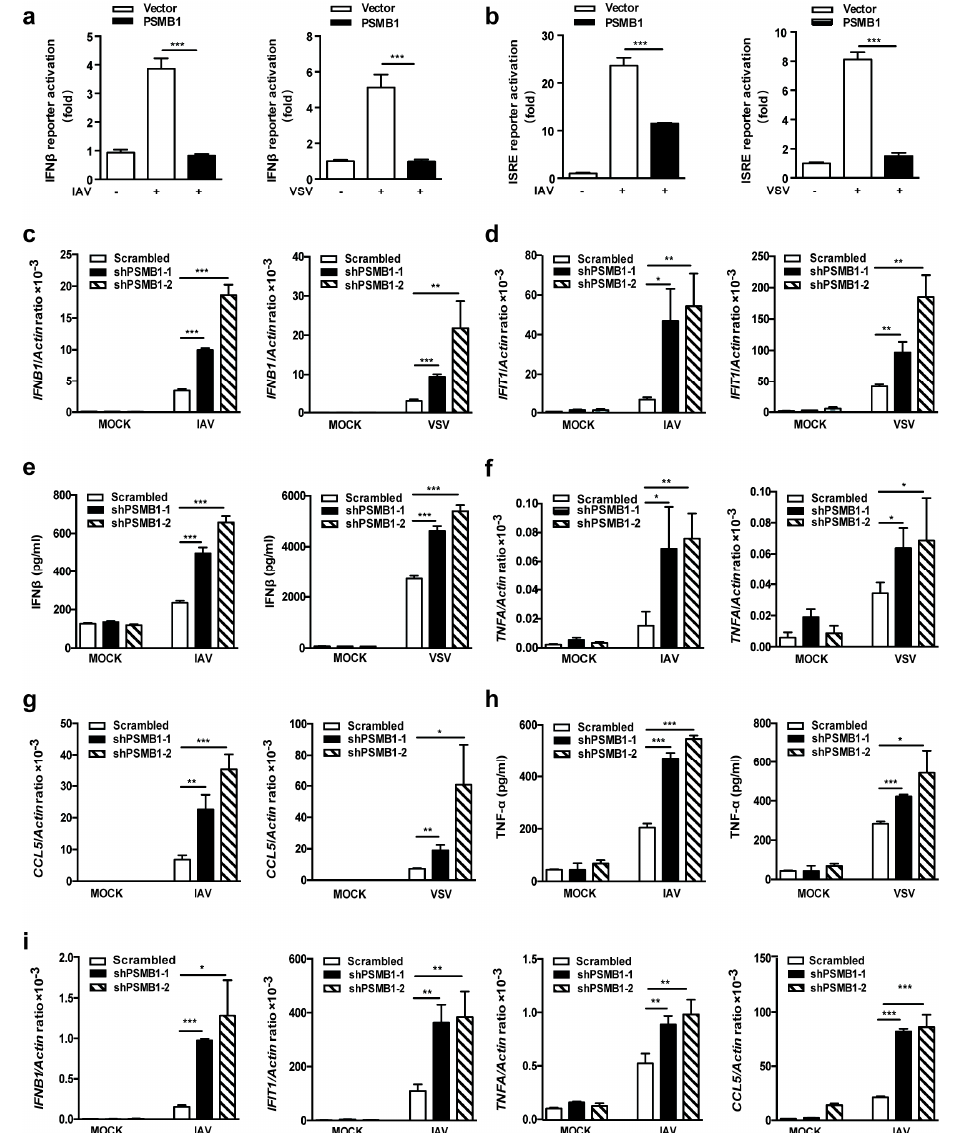
Figure 2. PSMB1 negatively regulates RNA virus-induced innate immune responses. ( a , b ) Quantification of IFN β and ISRE promoter activities in HEK293T cells transfected with either empty vector or PSMB1 plasmid after IAV or VSV infection. ( c – e ) Quantification of IFNB1 and IFIT1 mRNA levels by qPCR (c, d) and secreted interferon beta (IFN β ) protein levels (e) from HEK293T cells stably expressing either scrambled shRNA or PSMB1 -targeting shRNA after IAV infection (MOI = 1) for 24 h or VSV infection (MOI = 0.1) for 12 h. ( f – h ) Quantification of TNFA and CCL5 mRNA levels by qPCR (f, g) and secreted tumor necrosis factor alpha (TNF- α ) levels by ELISA (h) from HEK293T cells stably expressing either scrambled shRNA or PSMB1 -targeting shRNA after IAV infection (MOI = 1) for 24 h or VSV infection (MOI = 0.1) for 12 h. ( i ) Quantification of indicated cytokine and chemokine mRNA levels by qPCR from A549 cells stably expressing either scrambled shRNA or PSMB1 -targeting shRNA after IAV infection (MOI = 1) for 24 h. Data shown are the mean ± SEM; * p < 0.05, ** p < 0.01, *** p < 0.001. Representative results are from at least three independent experiments.